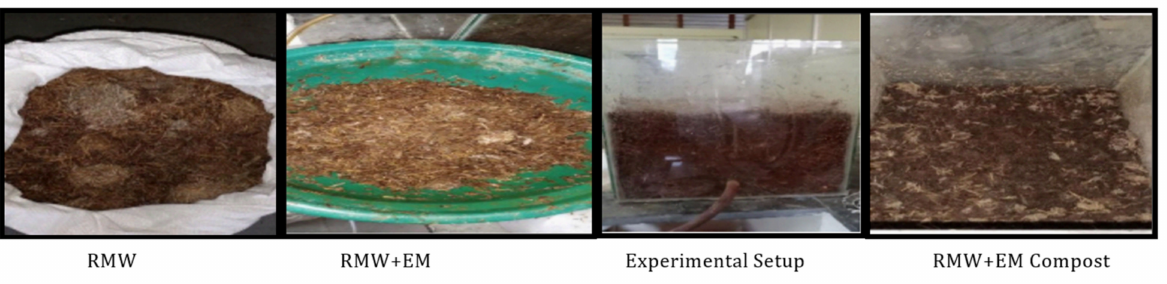
Figure 3. Set up 2 shows the images of raw mushroom waste with EM